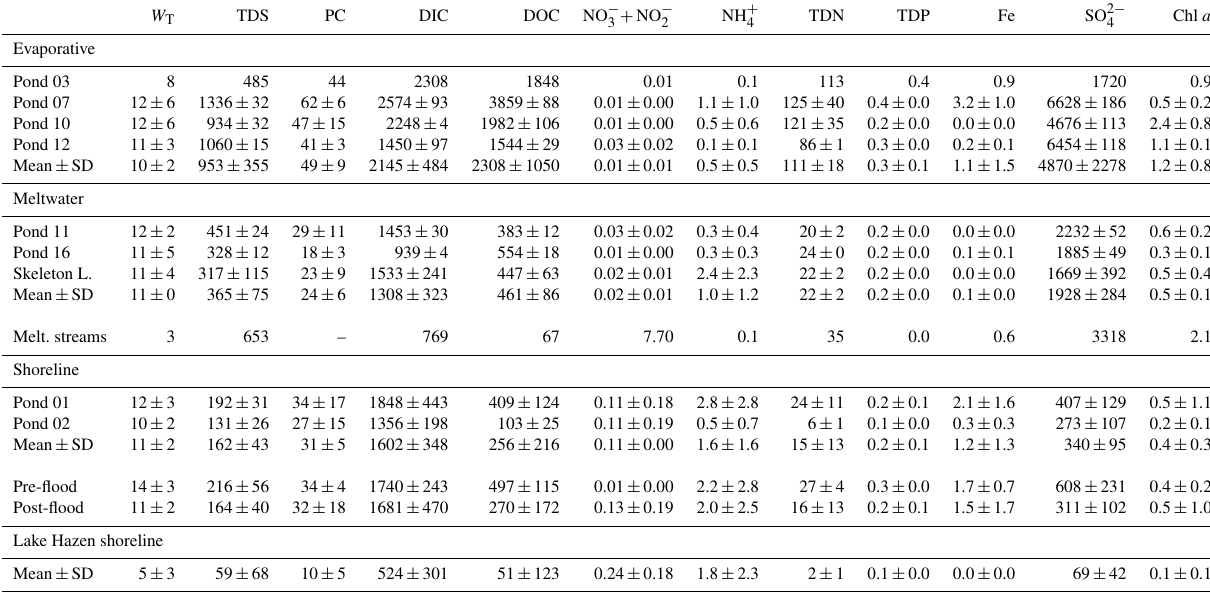
Table 3. Mean ( ± 1 SD) water temperature and general chemistry of different freshwater types, and other selected locations and periods in the Lake Hazen watershed during the growing seasons (June–August) of 2005 and 2007–2012. All measurements are in µmolL − 1 except for water temperature ( ◦ C), total dissolved solids (mgL − 1 ) , and chlorophyll a (µgL − 1 )